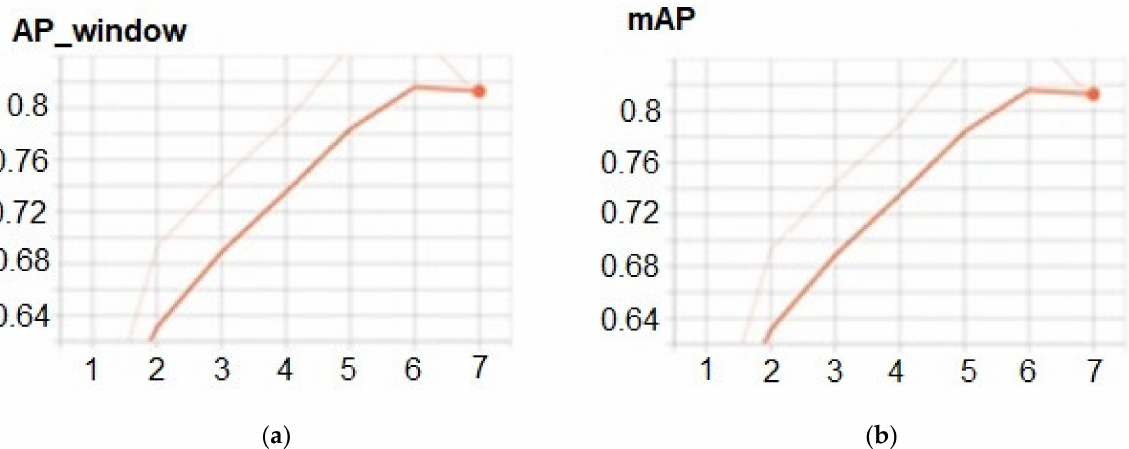
Figure 2. Training parameters for SSWD dataset: ( a ) average precision for window detection; ( b ) mean average